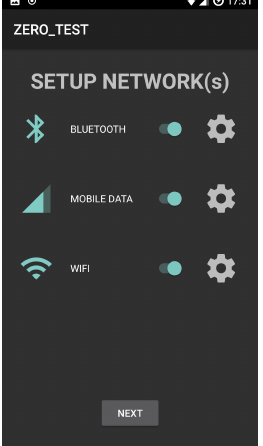
Figure 7. Communication interface selection